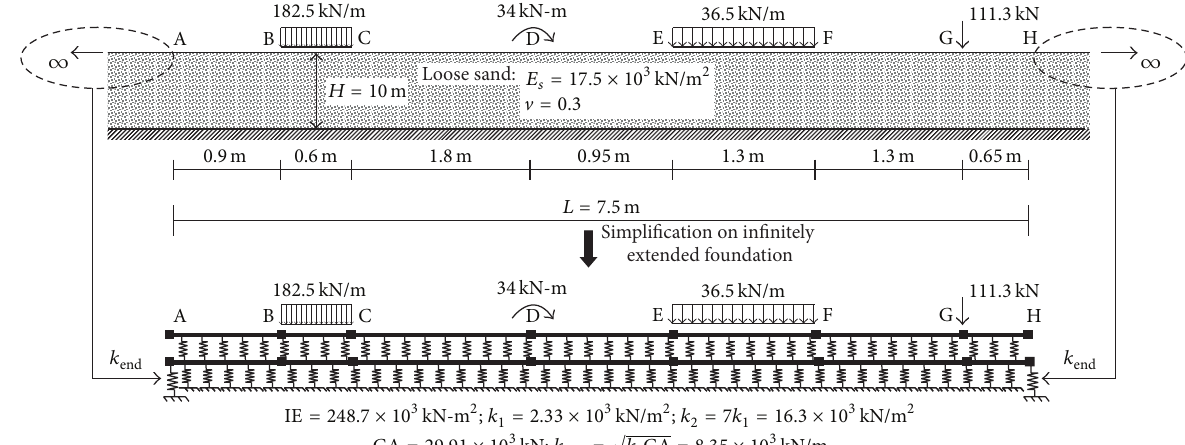
Figure 3: Numerical example: free-free beam on Kerr-type foundation subjected to various loads along its length.